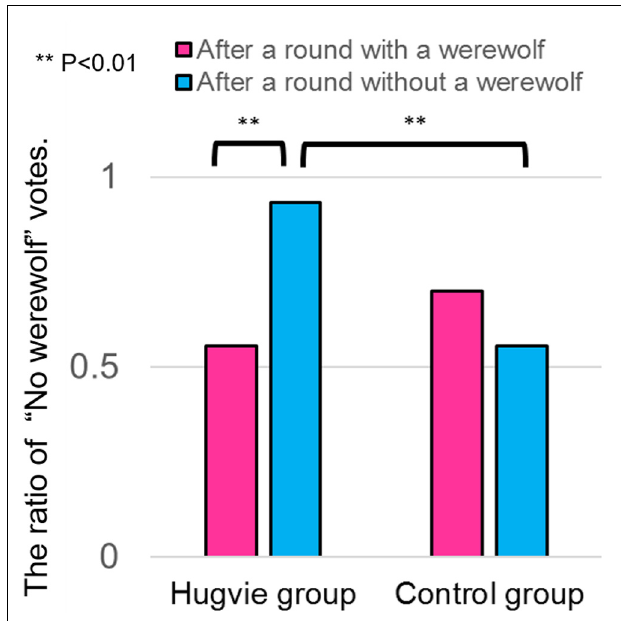
FIGURE 6 | Ratio of “No werewolf” votes after a round with/without a werewolf for each